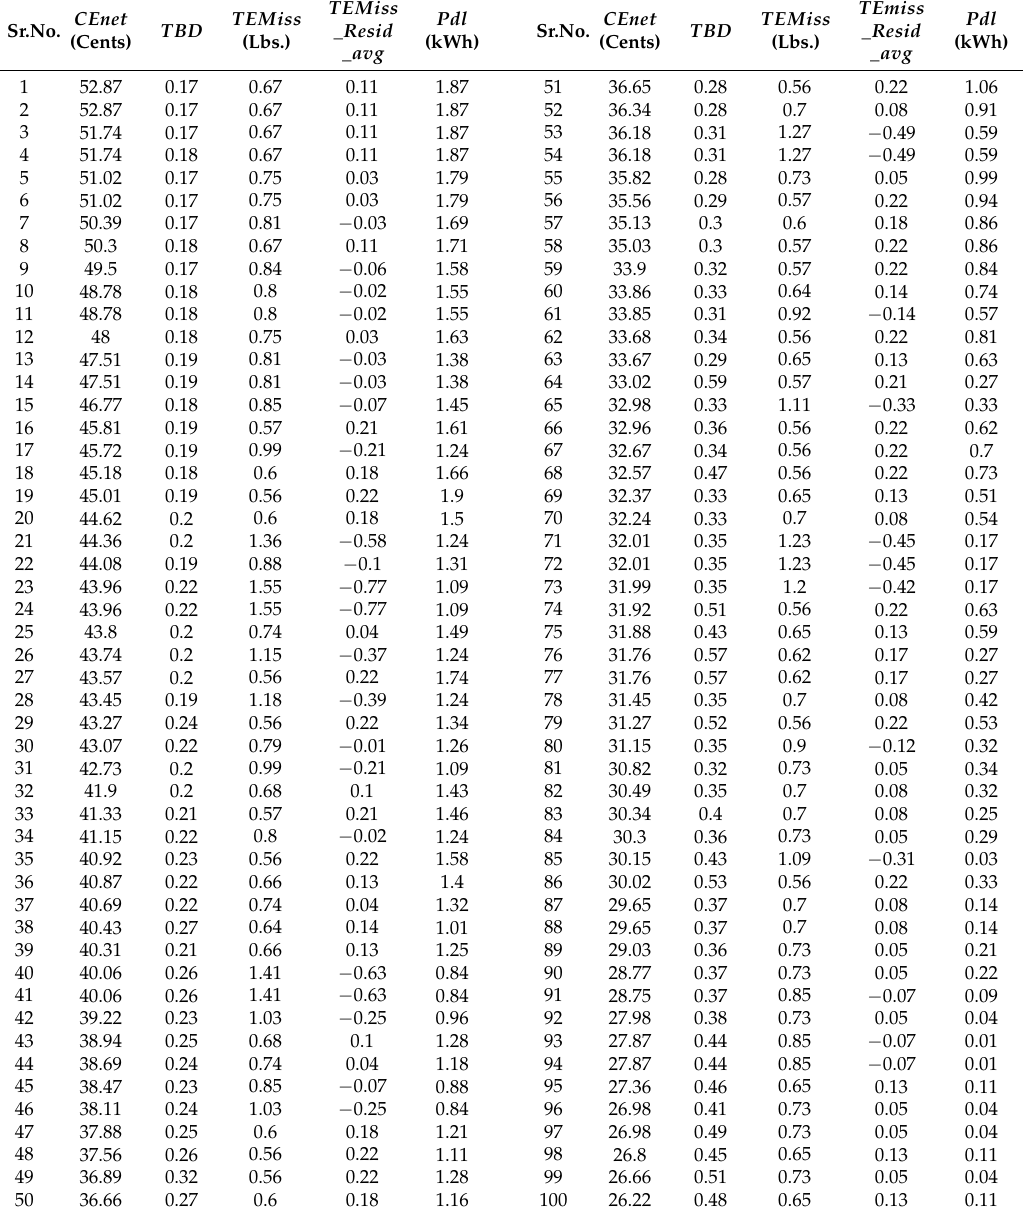
Table 10. Primary trade-offs for DRSREODLDG-BASED HEMS using Algorithm 1 (Step-1). CEnet Sr.No.